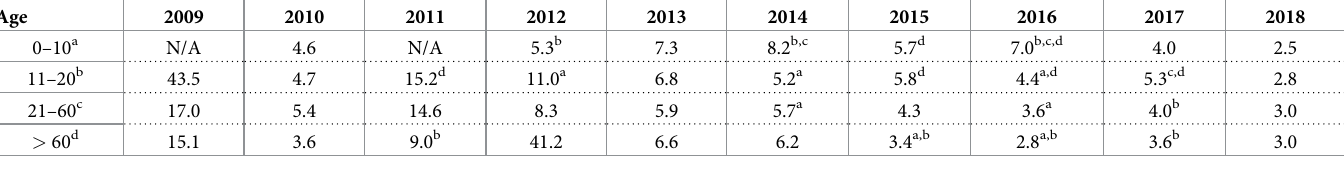
Table 6. Mean 137 Cs concentration (Bq/kg) in each age group from 2009 to